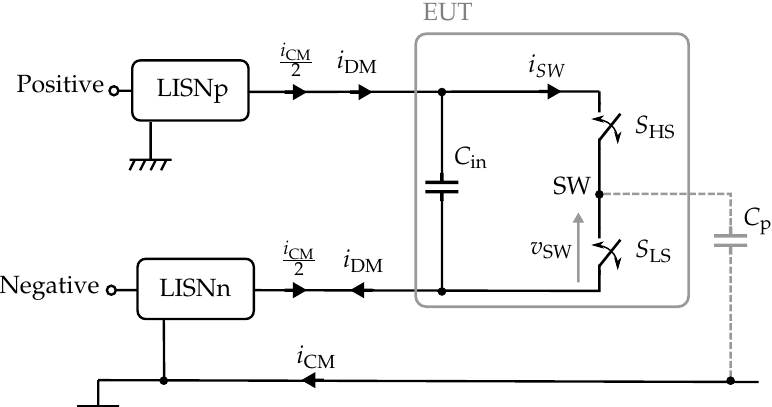
Figure 1. Conducted emission setup for a single leg. The differential- mode (DM) and common-mode (CM) currents are highlighted, as well as their major sources, i.e., the switching current ( i sw ) and the switching voltage ( v sw ),